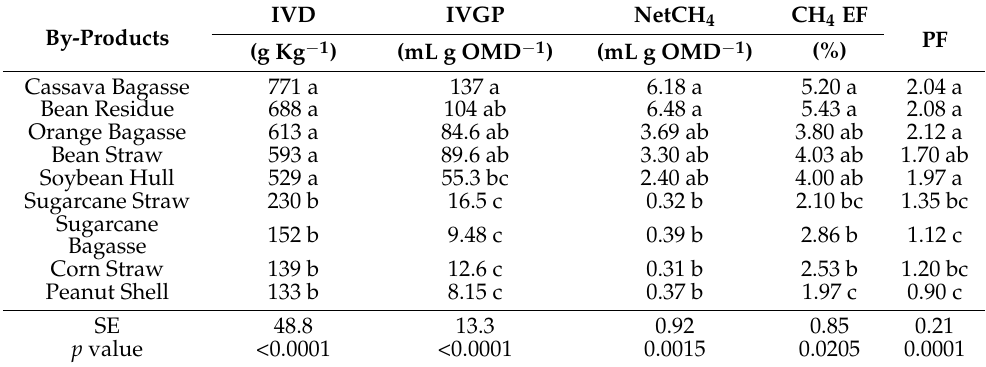
Table 2. In vitro degradability, in vitro gas production, net methane, and the partitioning factor for the evaluated by-products.